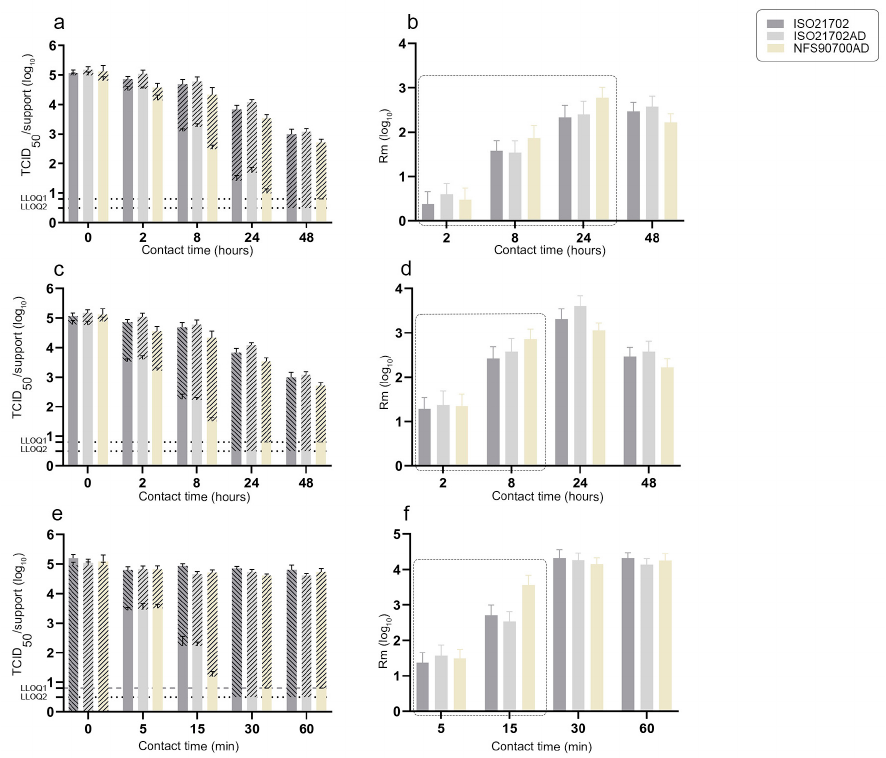
Figure 2. Amount of infectious H3N2 influenza virus at 0, 2, 8, 24 and 48 h post application ( a , c ) or at 0, 5, 15, 30 and 60 min post application ( e ) on both active surfaces (plain box) and stainless steel supports (hatched box) according to ISO21702, ISO21702AD and NFS90700AD protocols (mean ± SD, 9 supports/condition). Average antiviral activity Rm (log 10 TCID 50 /cm 2 ) including its 95% confidence interval (Kr, 3 independent experiments) according to ISO21702, ISO21702AS and NFS90700AD protocols. ( a , b ): AS01; ( c , d ): AS02; ( e , f ): AS03. LLOQ: lower limit of quantification (LLOQ2 = 0.5 log 10 TCID 50 for the ISO21702/ISO21702AD protocols and LLOQ1 = 0.8 log 10 TCID 50 for the NFS90700AD protocol). The residual amount of calicivirus on AS01 and AS02 reached the lower limit of quantification at 48 h post application according to all three protocols (Figure 3a,c).